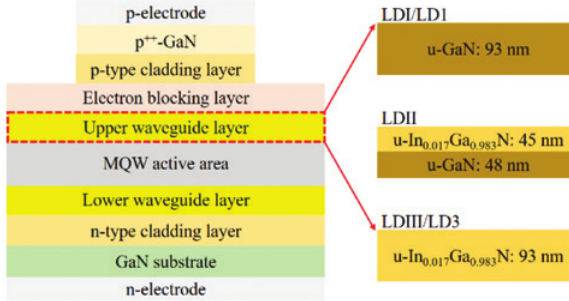
Figure 1: The schematic structure of the GaN-based LDs with different upper waveguide.